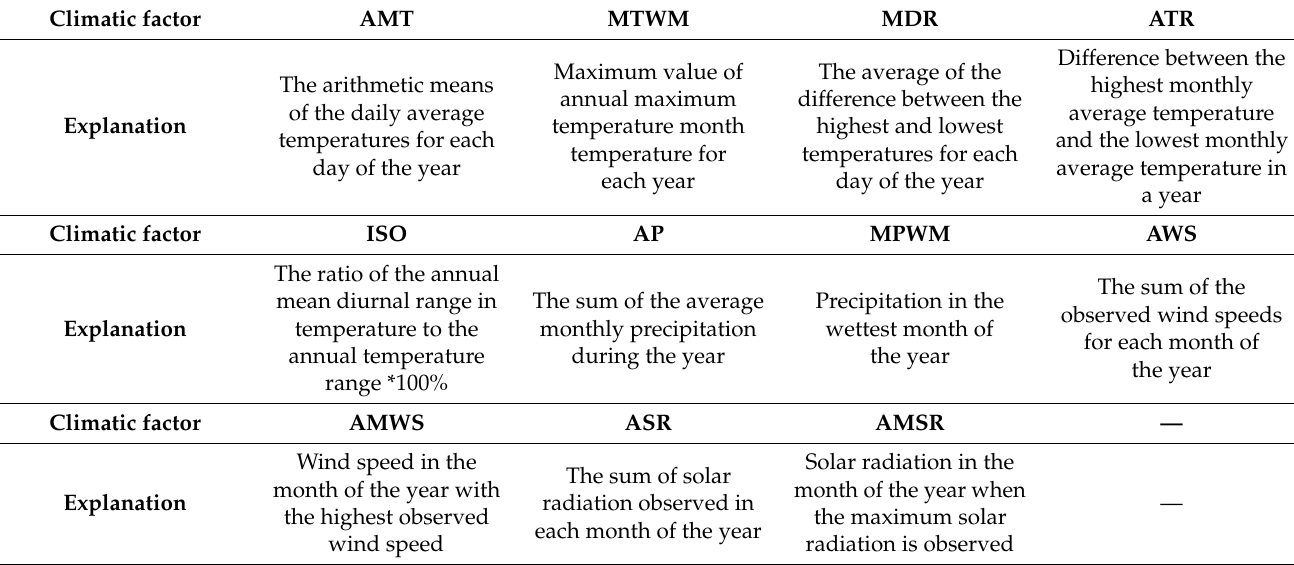
Table 1. Definition of climate-independent variables.